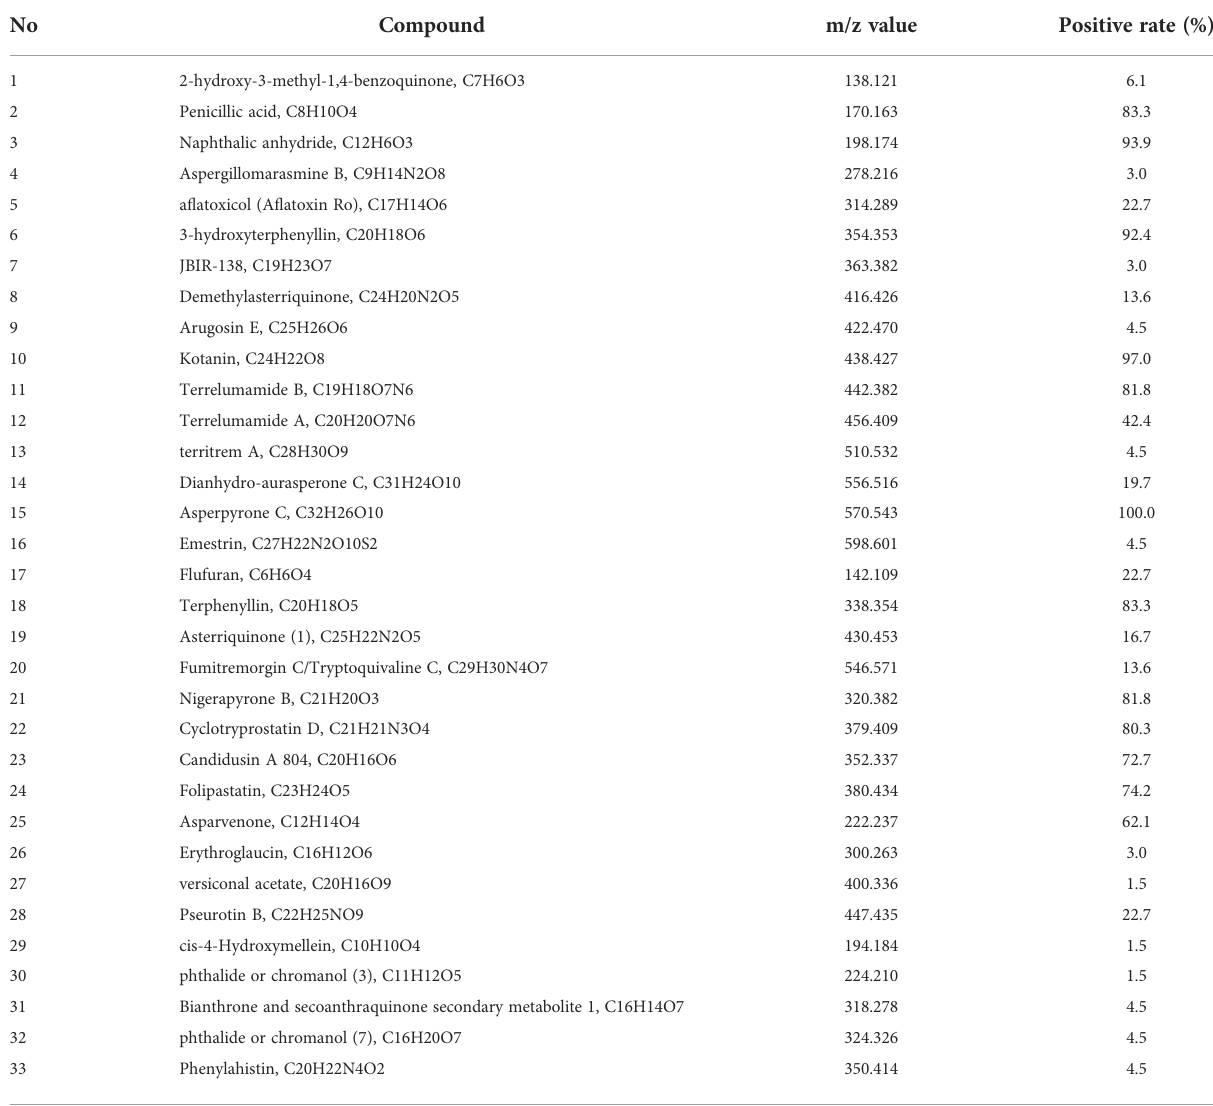
TABLE 2 Positive rates for 47 metabolites identi fi ed in EBC samples among patients with